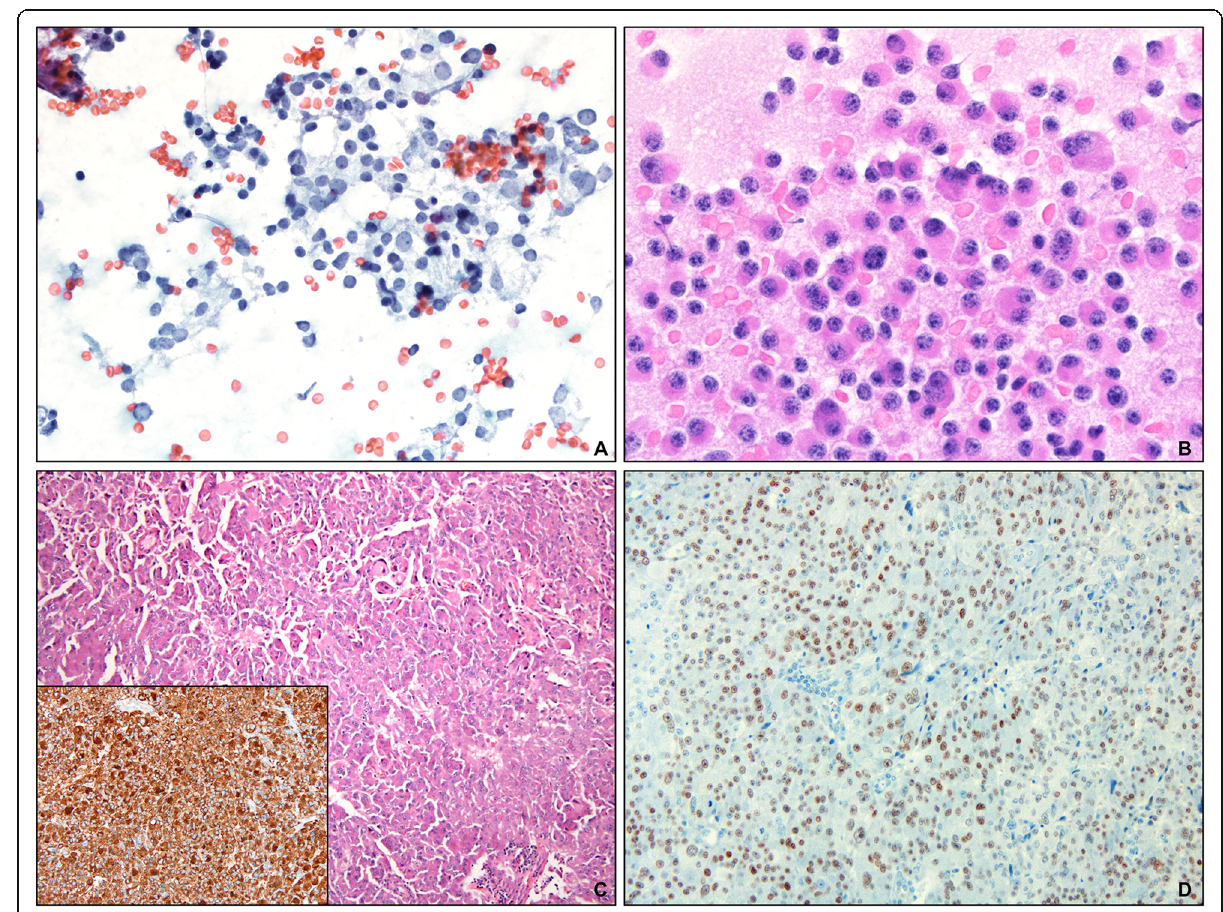
Fig. 1 a Pap-stained cytologic smears from fine needle aspiration of the liver masses (Original magnification × 400) showing characteristic nuclear features of neuroendocrine neoplasm. b Diff Quik stained slides showing cells with eccentric nuclei and binucleate cells (Original magnification × 600). c The liver was infiltrated by monotonous cells with abundant eosinophilic cytoplasm, open chromatin and visible nucleoli (Original magnification × 100). Inset: The tumor cells were diffusely positive for chromogranin (Original magnification × 200). d The tumor cells were also diffusely positive for T-PIT immunohistochemistry (Original magnification ×